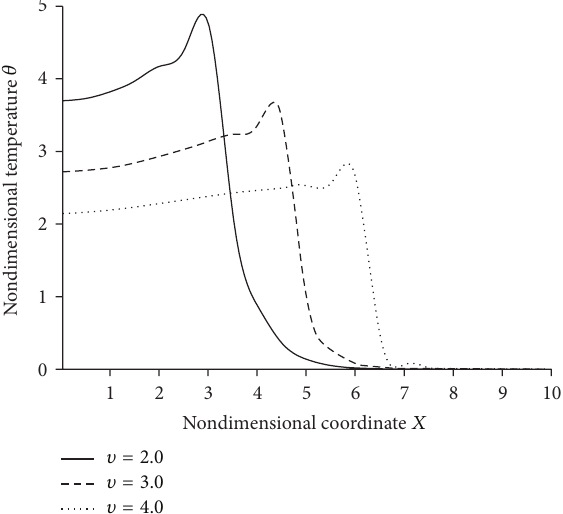
Figure 2: Nondimensional stress distribution for different 𝑡 values.